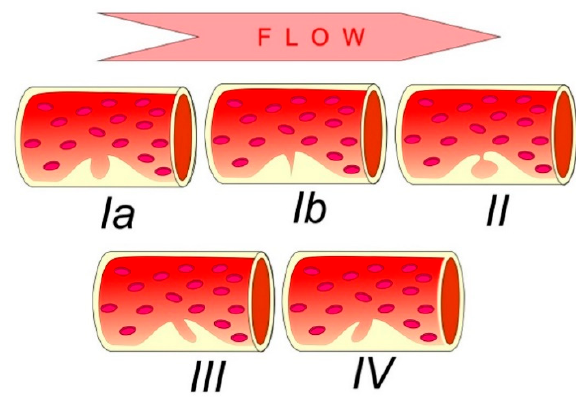
Figure 5. Schematic diagram showing the five morphologic types of carotid plaque ulcerations. Ulcer perpendicular to lumen with parallel (type Ia) or converging (type Ib) sides. Type 2: ulcer with narrow neck (“mushroom shaped”). Ulcer oriented parallelly (type III) or antiparallelly (type IV) to blood flow direction. Familiarity with these types will help identification of ulcerations.